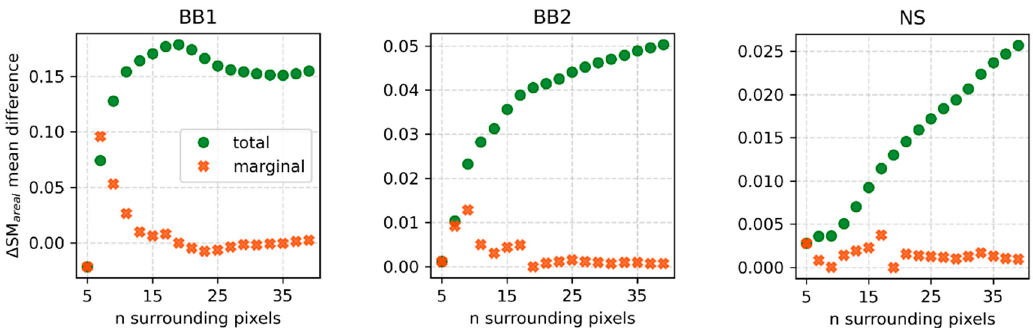
Figure 3. Benefit of employing larger grid sizes to calculate ΔSM areal compared to the smallest possible grid, i.e., n = 3 (green dots), and marginal improvements obtained for grid size n compared to the previous grid size, i.e., n − 2 (orange crosses).